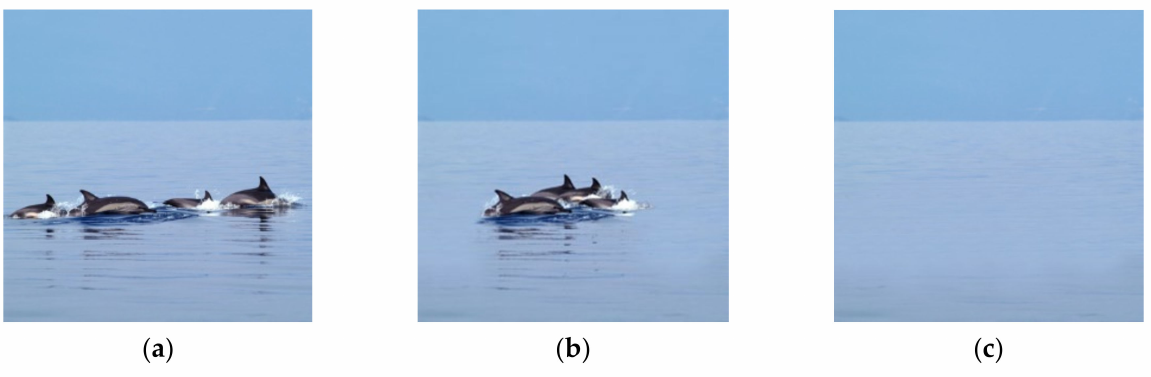
Figure 2. ( a ) Herd of dolphins; ( b ) clustered herd of dolphins; ( c ) scene without